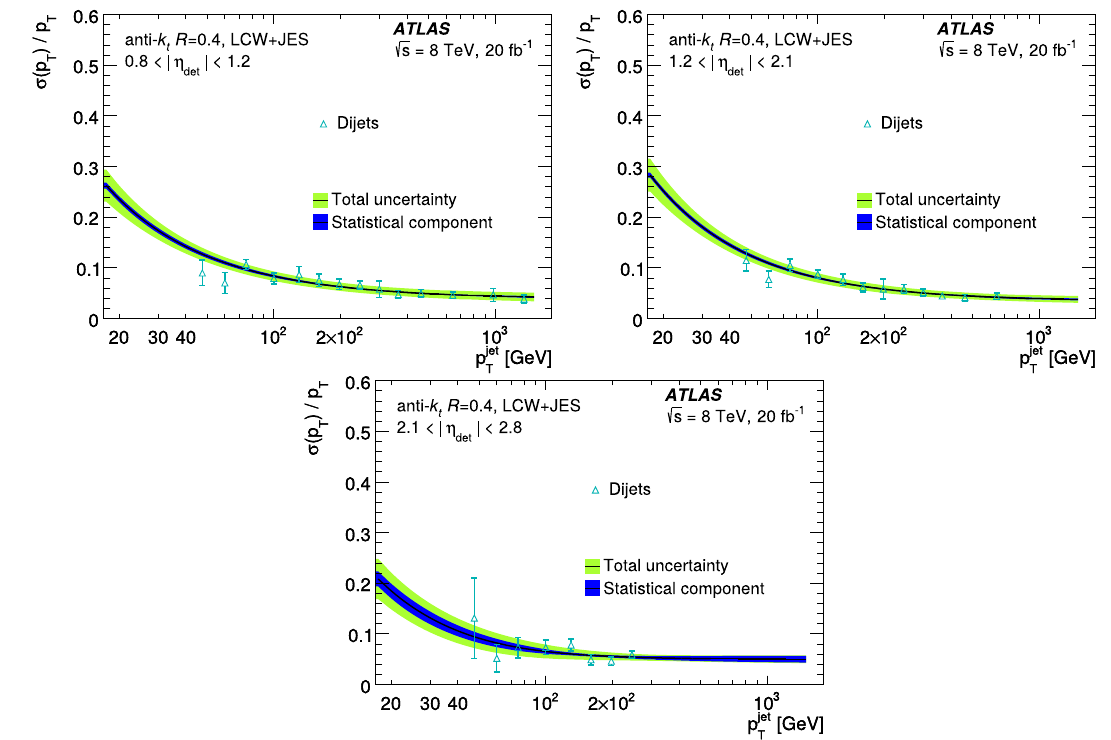
Fig. 58 The jet resolution as a function of p T for LCW+JES anti- k t R = 0 . 4 jets in three more-forward regions. The dijet in situ inputs (empty triangles) to the measurement are shown. The final fit using the function in Eq. (24) is included with its associated statistical and total uncertainty Table 6 Extracted values of the N , S , and C terms from a combined fit to the jet energy resolution measurements for R = 0 . 4 and R = 0 . 6 jets, both calibrated with the EM+JES scheme. The quoted uncertainties of the N , S , and C terms are highly correlated with each other | η | Range EM+JES, R = 0 . 4 EM+JES, R = 0 . 6